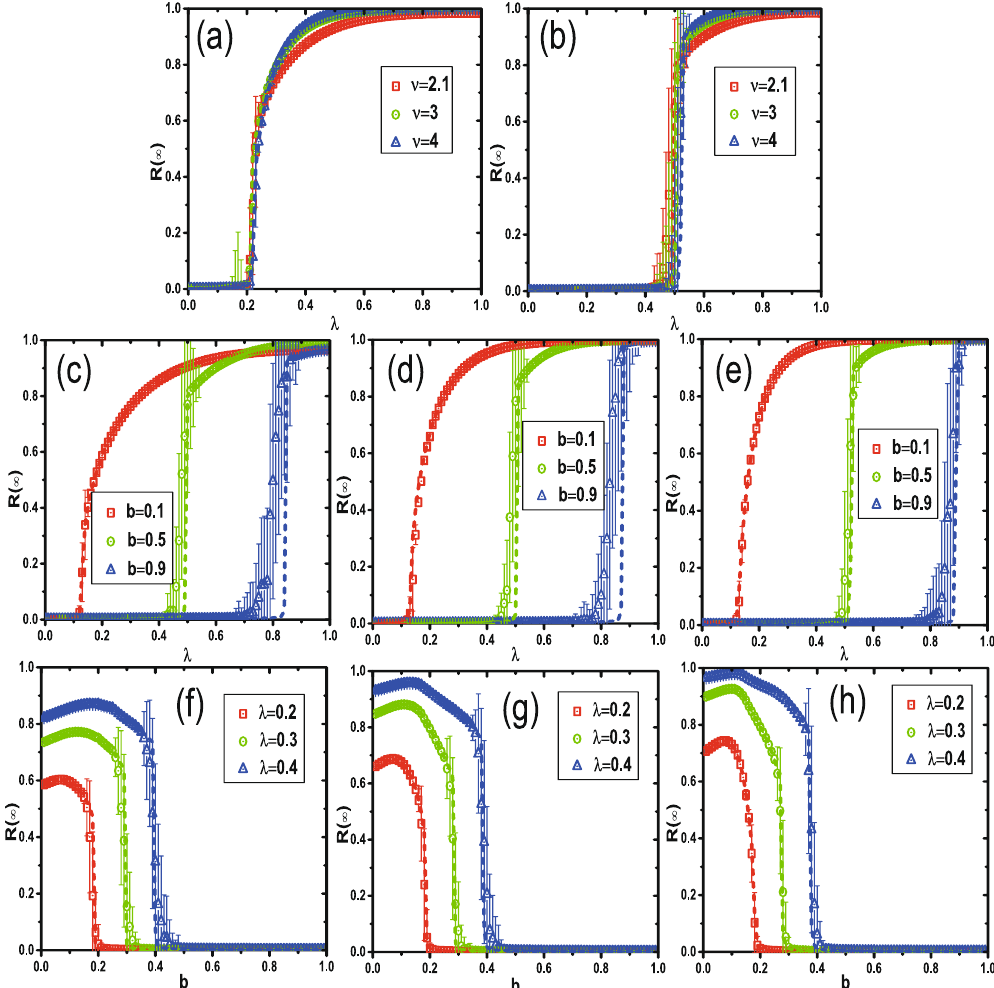
Figure 6. Effect of network heterogeneity in social contagion dynamics. For scale-free network with mean degree 〈 k 〉 = 10 and network size N = 10000, dependence of R ( ∞ ) on b , v , and λ is explored under parameter values. Subgraph ( a ) and ( b ) demonstrate the impact on R ( ∞ ) of separate degree exponent v , respectively under b = 0.2 and 0.5. Then, subgraph ( c – e ) exhibit the results of b influencing R ( ∞ ), referring to degree exponent v = 2.1, 3, and 4. Furthermore, for rigorousness, subgraph ( f – h ) proceed to show the changes of R ( ∞ ) based on different transmission probability λ , also separately under v = 2.1, 3, and 4. As expected, the theoretical solutions, denoted by dash line, perfectly coincide with numerical values, marked by